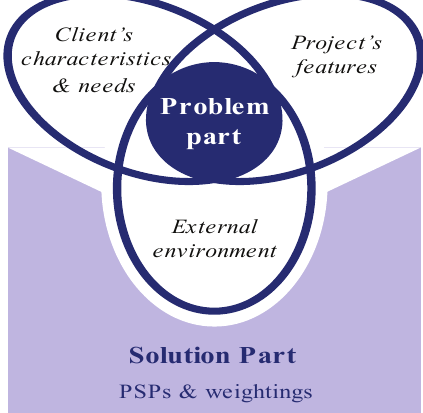
Figure 1: Knowledge pertinent to PSPs formulation stage